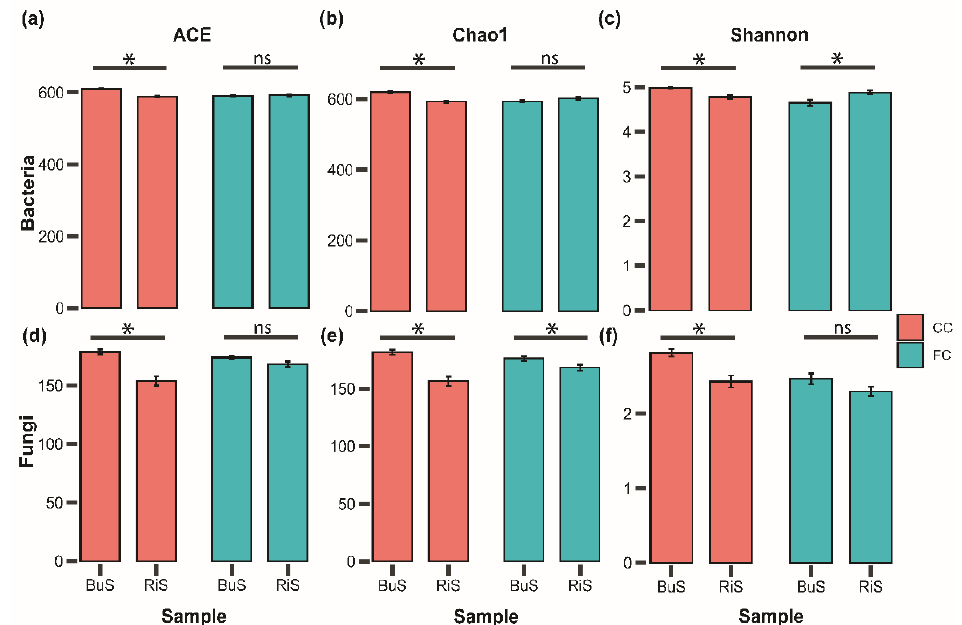
Figure 3. Alpha diversity indices of soil bacteria and fungi. The bar graph depicts alpha diversity